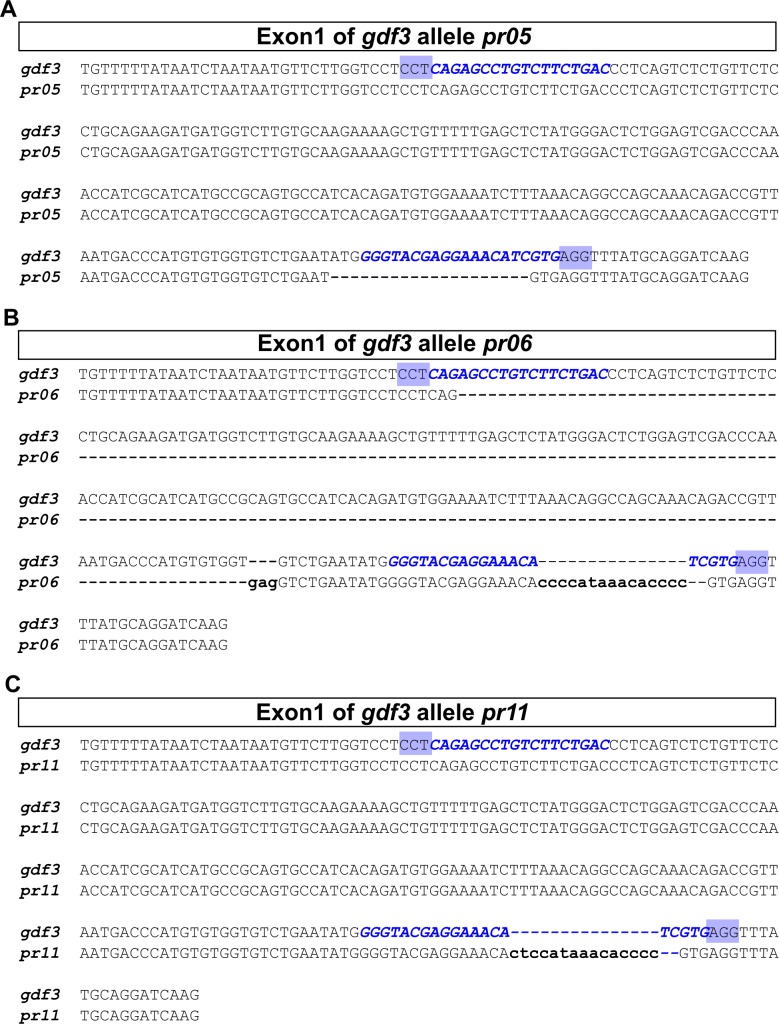
Schematic of gdf3 mutant allele sequences.The genetic changes generated using CRISPR/Cas9 are diagrammed. (A) gdf3 allele pr05 contains a 20 bp deletion. (B) gdf3 allele pr06 contains a 191 bp deletion and an 18 bp insertion, resulting in a net loss of 173 bp. (C) gdf3 allele pr11 contains a 2 bp deletion and a 15 bp insertion, resulting in a net insertion of 13 bp. The sgRNA target sites (blue text) and the PAM sites (blue highlights) are shown. Deletions are indicated by dashed lines in the mutant alleles. Insertions are represented by lowercase letters in the mutant (pr) sequence and corresponding dashed lines in the wild-type (gdf3) sequence.